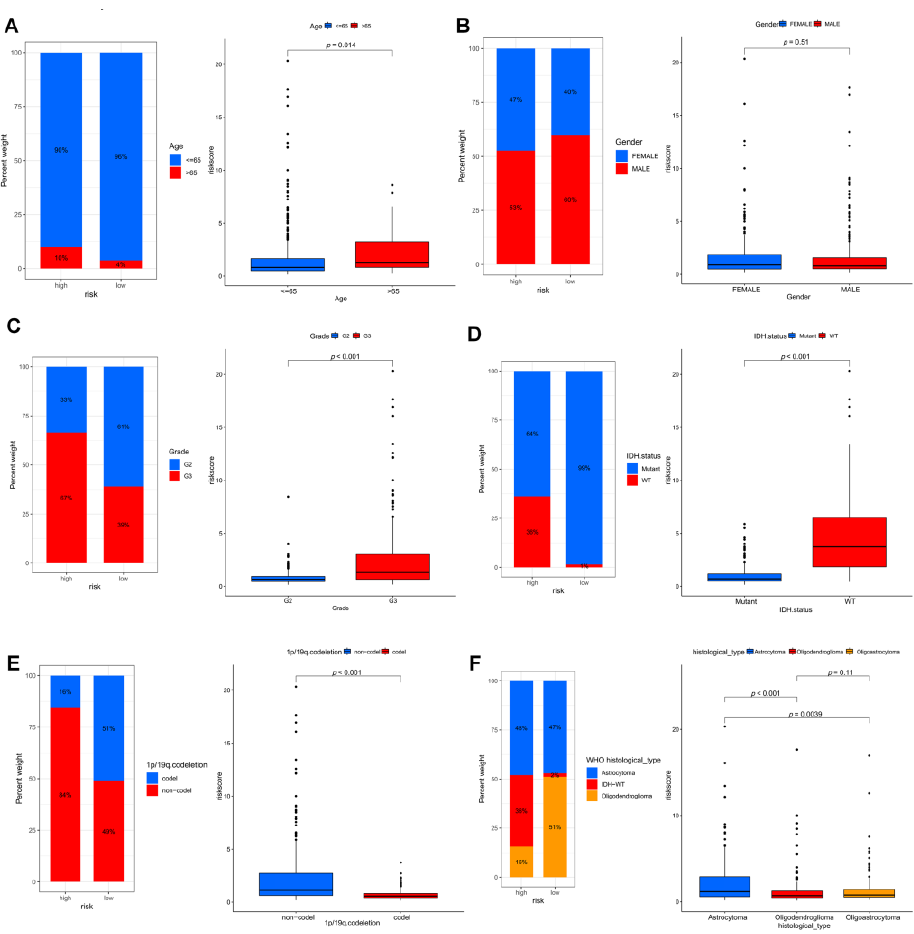
Figure 8. Differences in risk scores among different clinical characteristics subgroups in the TCGA cohort. ( A ) age, ( B ) gender, ( C ) grade, ( D) IDH mutation status, ( E ) 1p/19q. codeletion and ( F ) histological type of 2021 WHO.